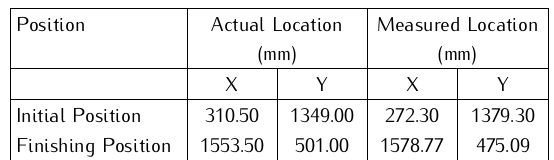
Table 4. Robot Path Following Performance